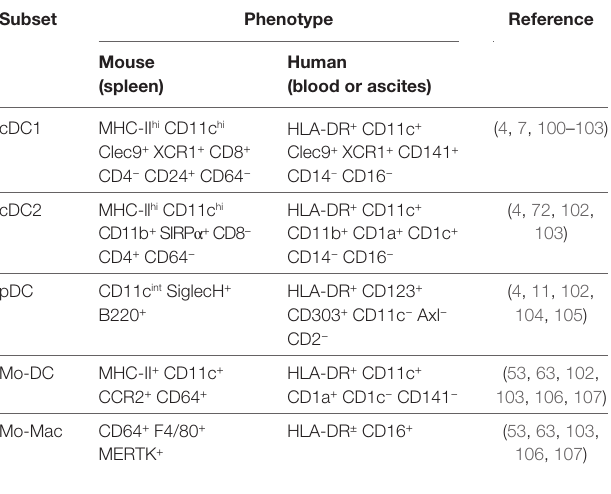
TabLe 1 | Different markers used to distinguishe mouse and human